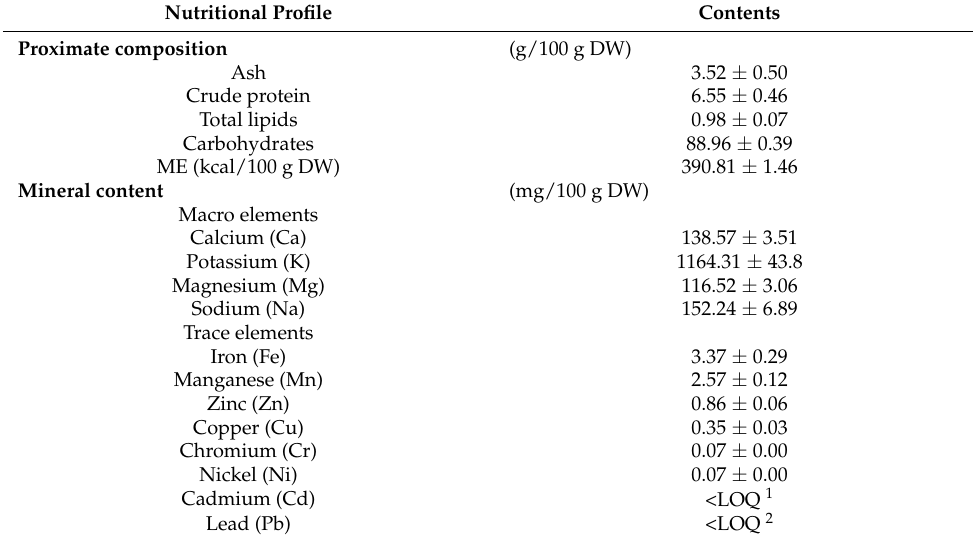
Table 1. Nutritional value of seeds from Cladium mariscus (sawgrass): proximate composition (ash, crude protein, total lipids, carbohydrates, and metabolizable energy—ME) and mineral content (macro and trace